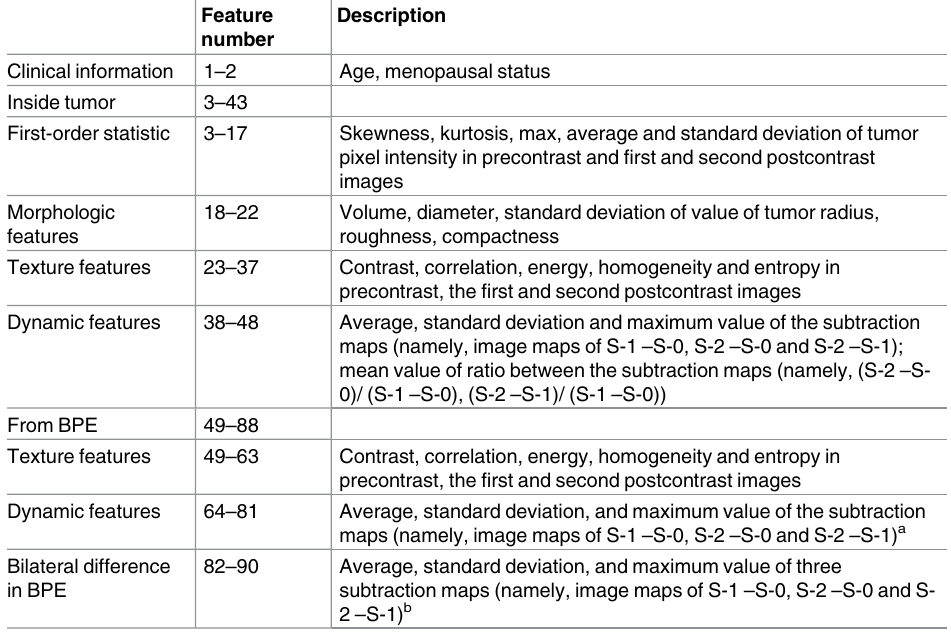
Table 1. Summary of extractedDCE-MR image